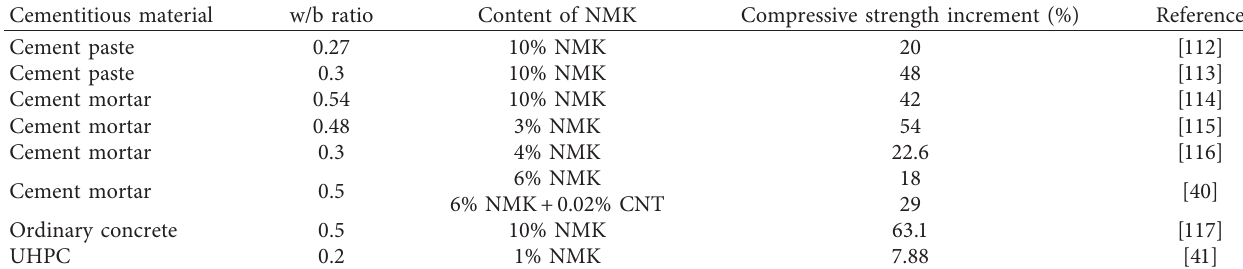
Table 3: Compressive strength of NMK cement-based materials at 28 days.